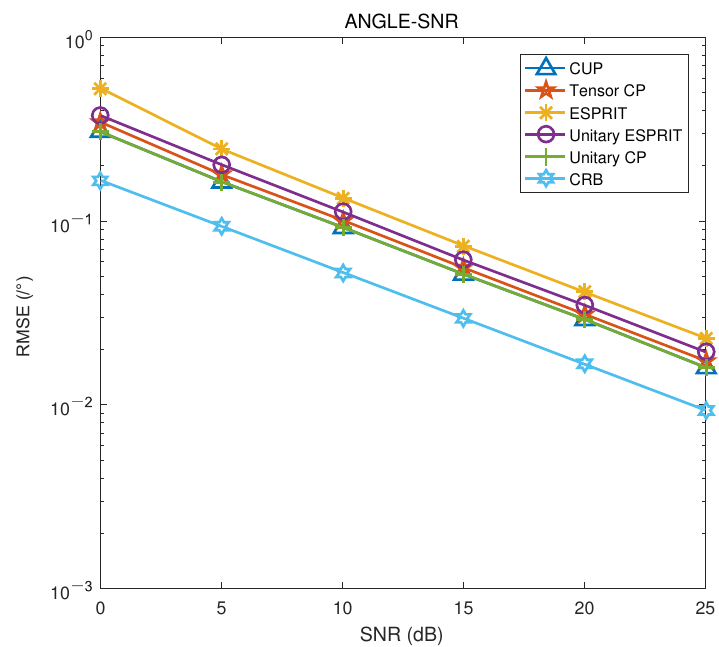
Figure 6. RMSE of angle estimation versus